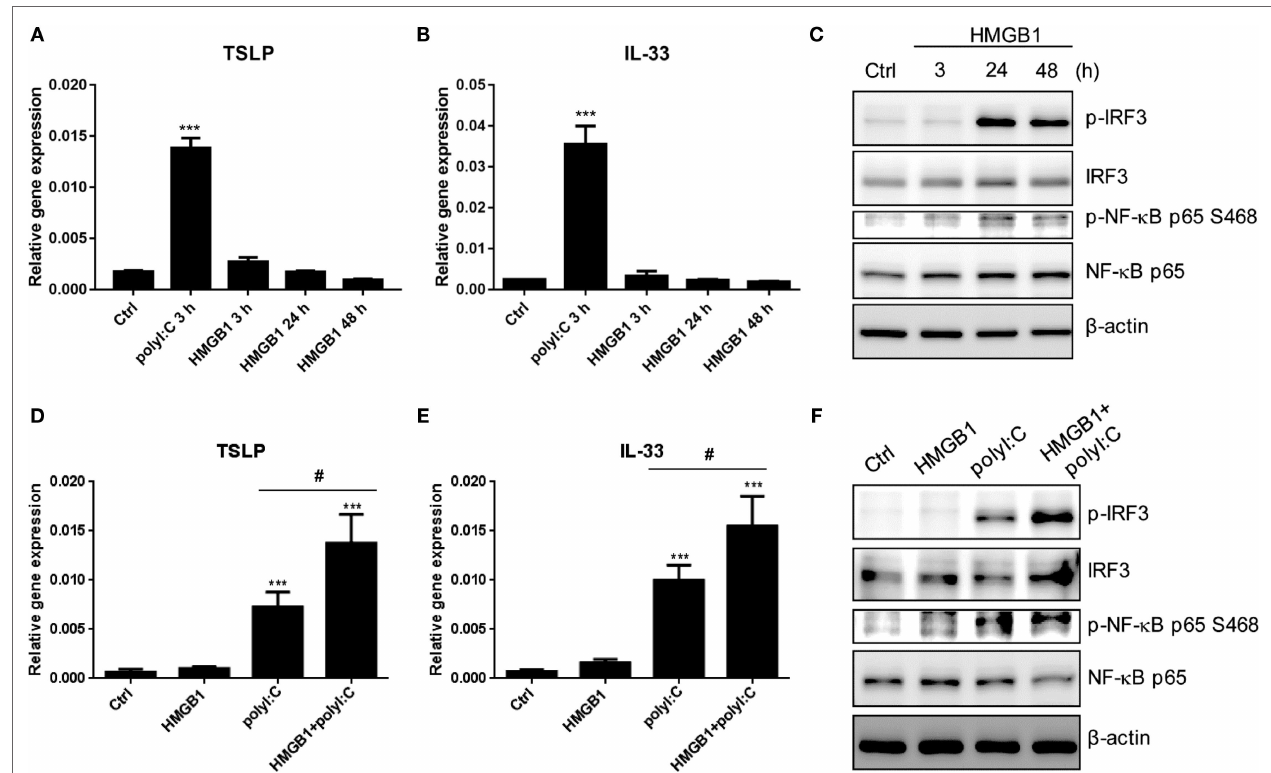
FigUre 8 | hMgB1 enhances polyi:c-stimulated TslP and il33 expression . (a,B) RT-qPCR analysis of TSLP and IL33 expression in H292 cells stimulated with polyI:C (2 μ g) for 3 h or HMGB1 (1 μ g/ml) for 3, 24, and 48 h. Data are mean ± SD from three independent experiments. *** P < 0.001 compared to control. (c) The whole cell extracts from H292 cells were harvested at 3, 24, and 48 h after HMGB1 (1 μ g/ml) stimulation. Immunoblotting analysis was performed with the indicated antibodies. Results are representative of three independent experiments. (D,e) H292 cells were pretreated with HMGB1 (1 μ g/ml) for 3 h, then stimulated with polyI:C for 3 h. The expression of TSLP and IL33 were monitored by RT-qPCR. Data are mean ± SD from three independent experiments. *** P < 0.001 compared to controls; # P < 0.05. (F) H292 cells were pretreated with HMGB1 for 3 h and then stimulated with or without polyI:C (1 μ g) for 3 h. Cell extracts underwent SDS-PAGE and immunoblotting with specific antibodies. Data shown are representative of three different